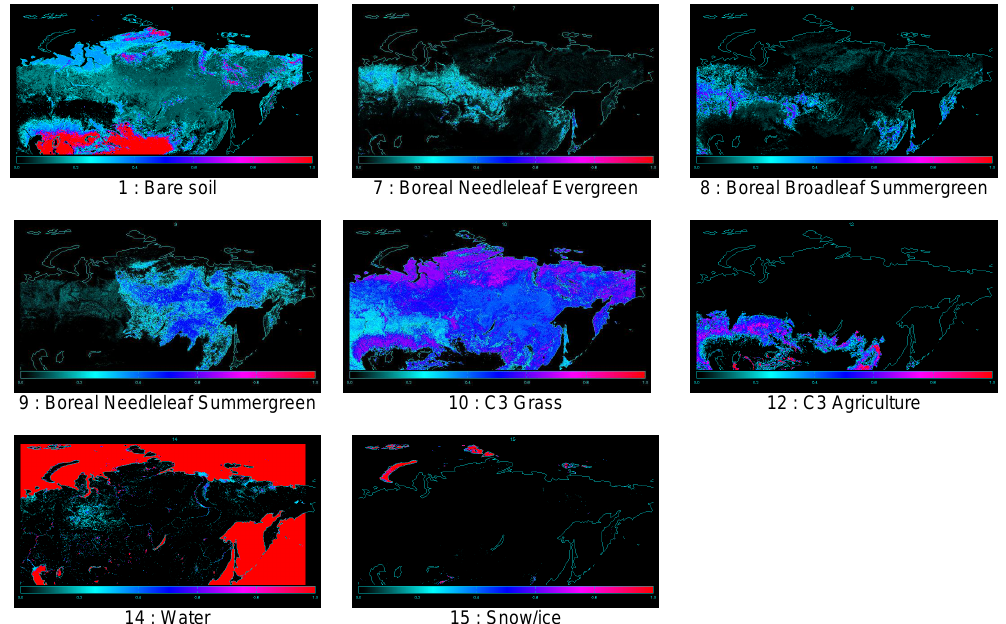
Figure 6. New ORCHIDEE PFT maps. The respective fractions of the following eight classes are represented in color scale, from blue (0%) to red (100%): bare soil (PFT1), boreal needleleaf evergreen (PFT7), boreal broadleaf summergreen (PFT8), boreal needleleaf summergreen (PFT9), C3 grass (PFT10), C3 agriculture (PFT12), water (PFT14), and snow / ice